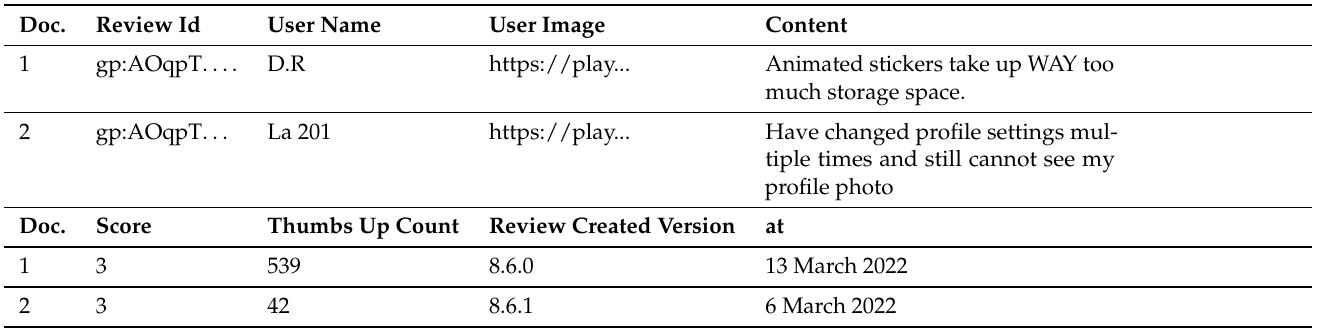
Table 4. Sample of the dataset.